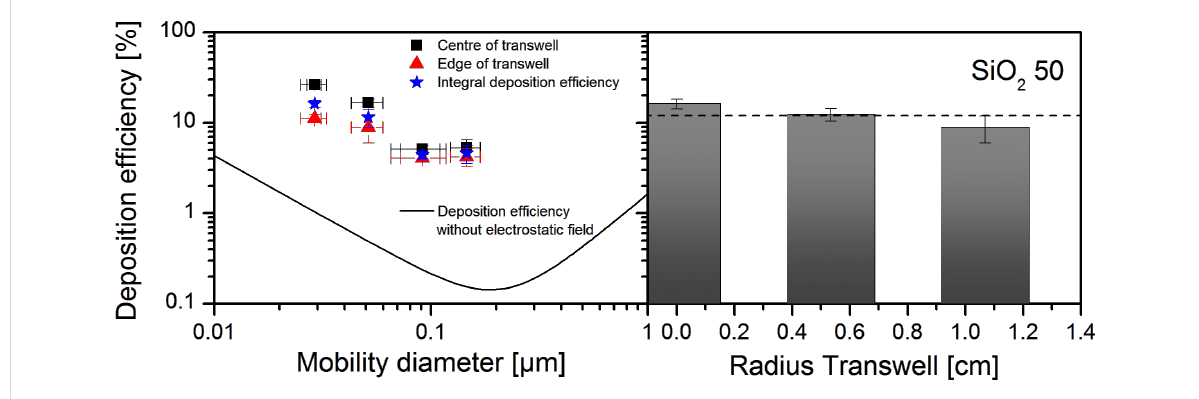
Figure 4: Deposition efficiency of SiO 2 monomers depending on particle size (left plot) with electrostatic field (symbols) and without electrostatic field (SiO 2 particle characteristics and drawn line as in Comouth et al. [18] and deposition efficiency of SiO 2 -50 nm monomers in dependence of the pos- ition on the Transwell surface (plot on the right)). SiO 2 -50 nm monomers were dispersed by electrospray and deposited on a Transwell surface with electrostatic field. The deposited mass was calculated from particle loadings on TEM grids at three different radial positions on the Transwell surface from the center to the edge. The dashed line indicates the averaged deposition efficiency. The results indicate a moderate but significant linear decrease of the particle loading between the center and the edge of the Transwell